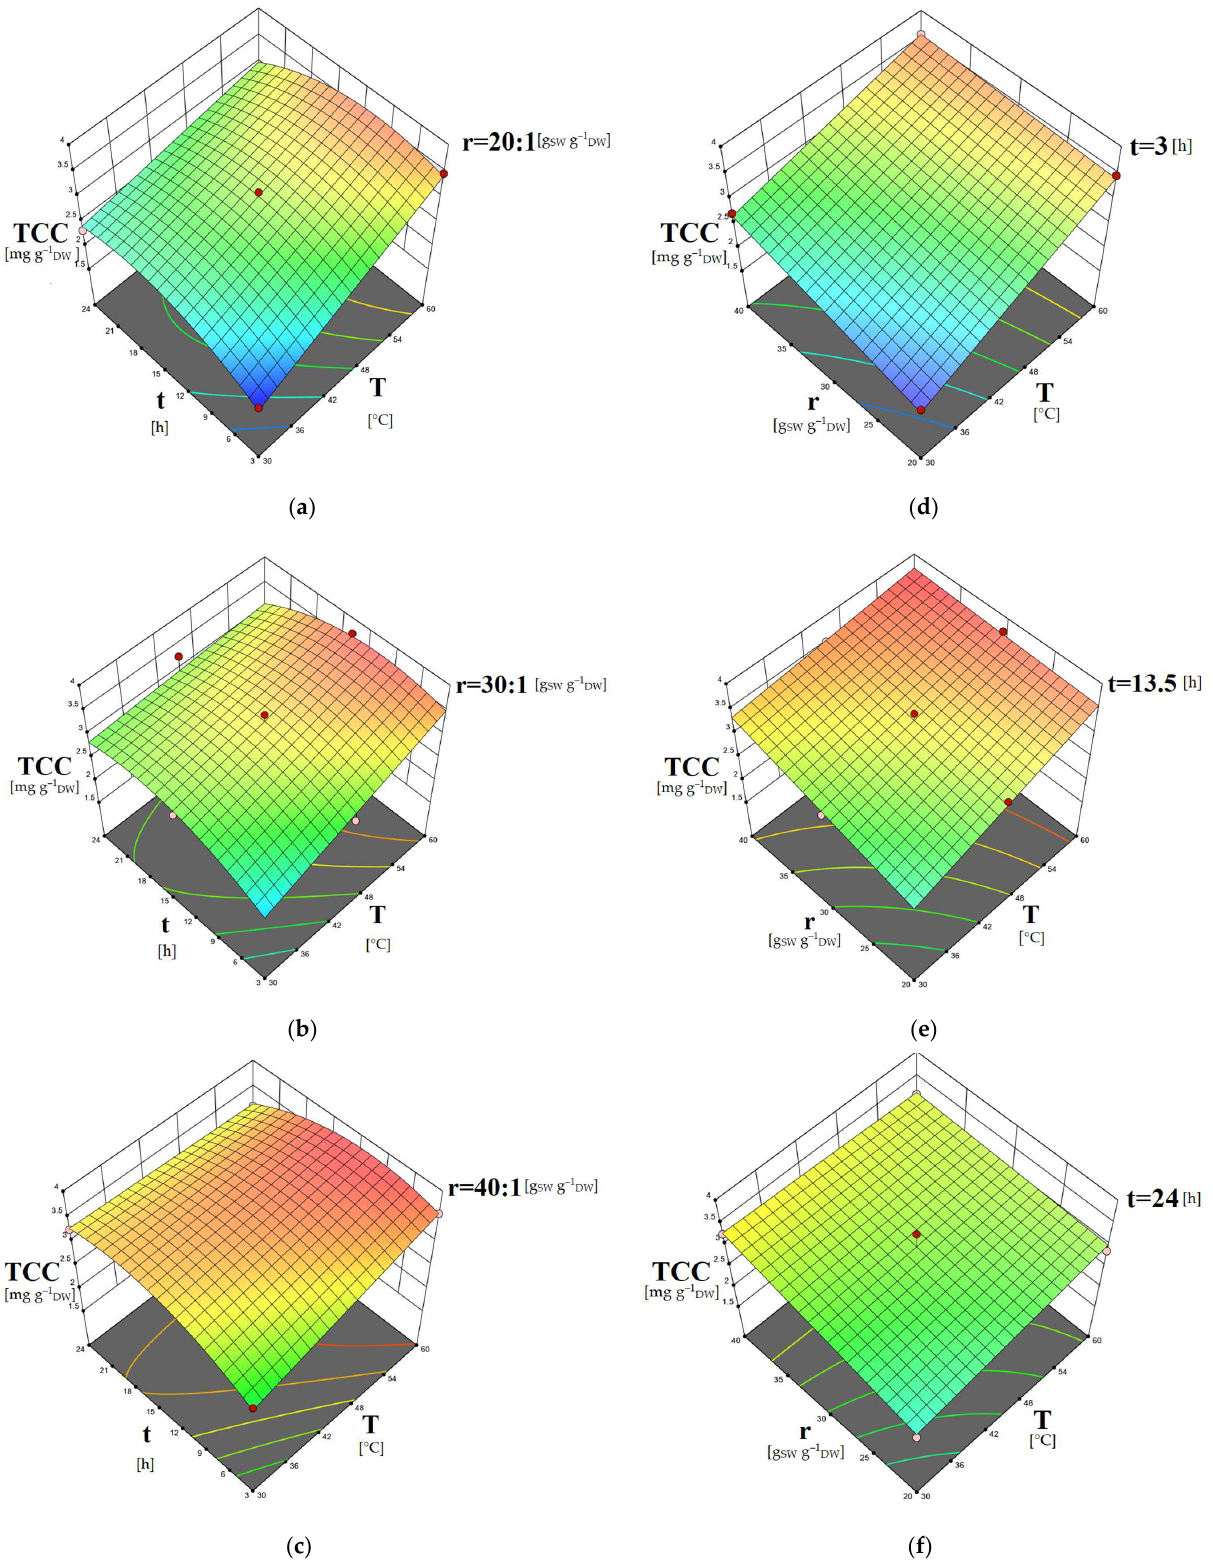
Figure 1. Three-dimensional surface plots showing the combined effects of temperature and time ( a – c ) and temperature and solvent-to-biomass ratio ( d – f ) on TCC [mg g –1DW ] of the C. vulgaris extracts obtained using DES1/w solvent.